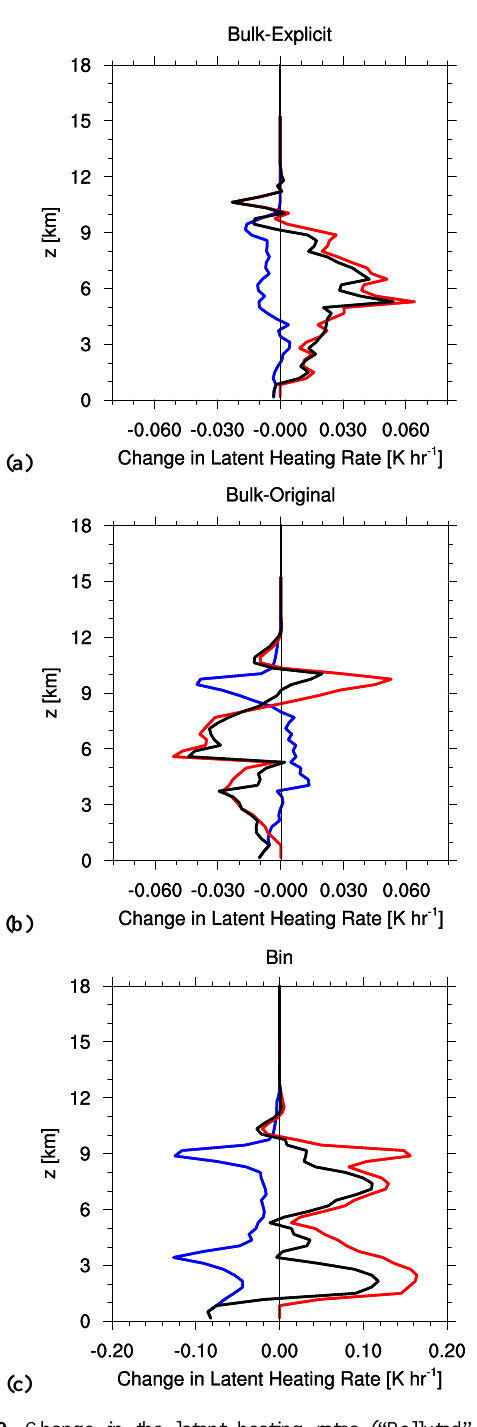
Fig. 10. Change in the latent heating rates (“Polluted” minus “Clean”) for the bulk-explicit (a) , bulk-original (b) , and bin (c) model configurations. Shown are the changes in heating (red), cool- ing (blue), and net (black) heating rates for an increase in aerosol loading. Here, positive values correspond to an increase in heating (or decrease in cooling) from the “Clean” to “Polluted”